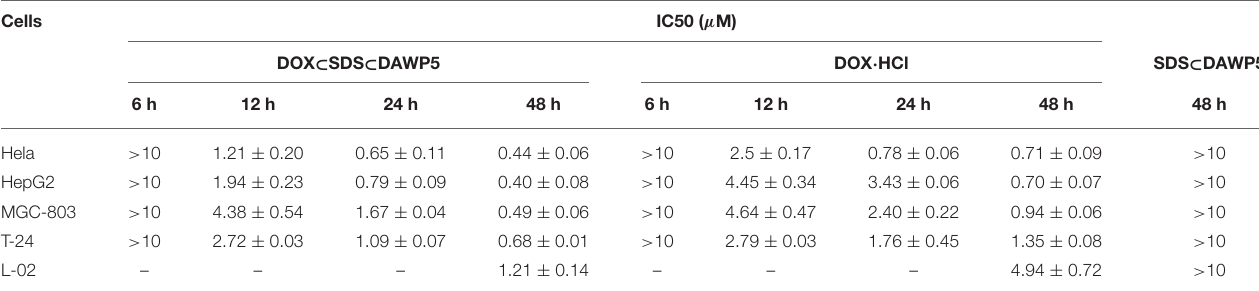
TABLE 1 | Inhibitor activities of vesicles SDSÌDAWP5, dox-loaded vesicles DOXÌSDSÌDAWP5, and free DOX · HCl against to four tumor cells and normal cell.